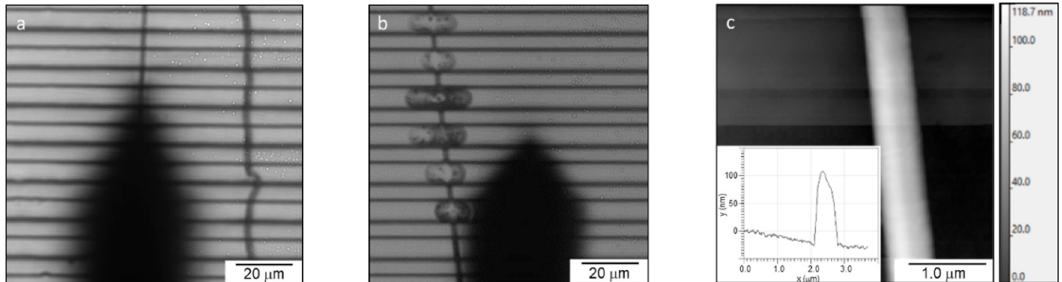
Figure 5. Electrospun 50:50 fibrinogen:PCL (poly- ε -caprolactone) fibers on striated substrate. ( a ) Optical microscopy image of two single fibers on the substrate with the AFM taking an image of one of the fibers. AFM probe is the black, pointed shape). ( b ) Optical microscopy image of an epoxy-anchored fiber. ( c ) AFM image of a single electrospun fiber on a ridge. The inset shows the cross-section of the fiber; fiber height (diameter), 135 nm.